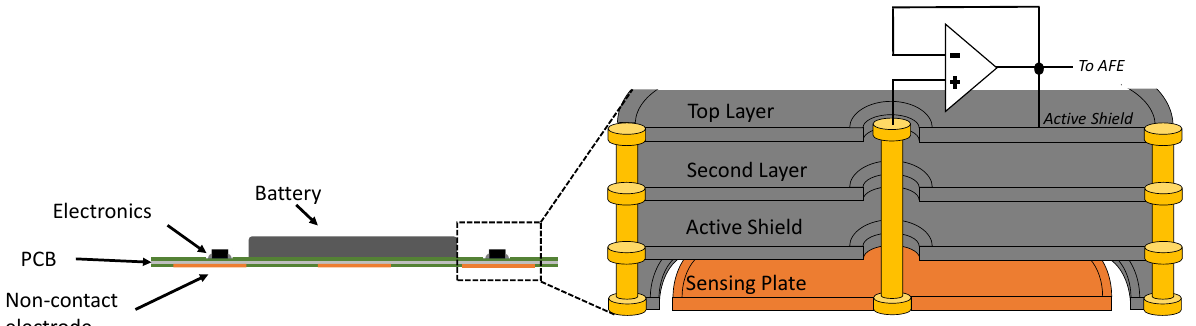
Figure 4. Cross-sectional view of the device and the non-contact